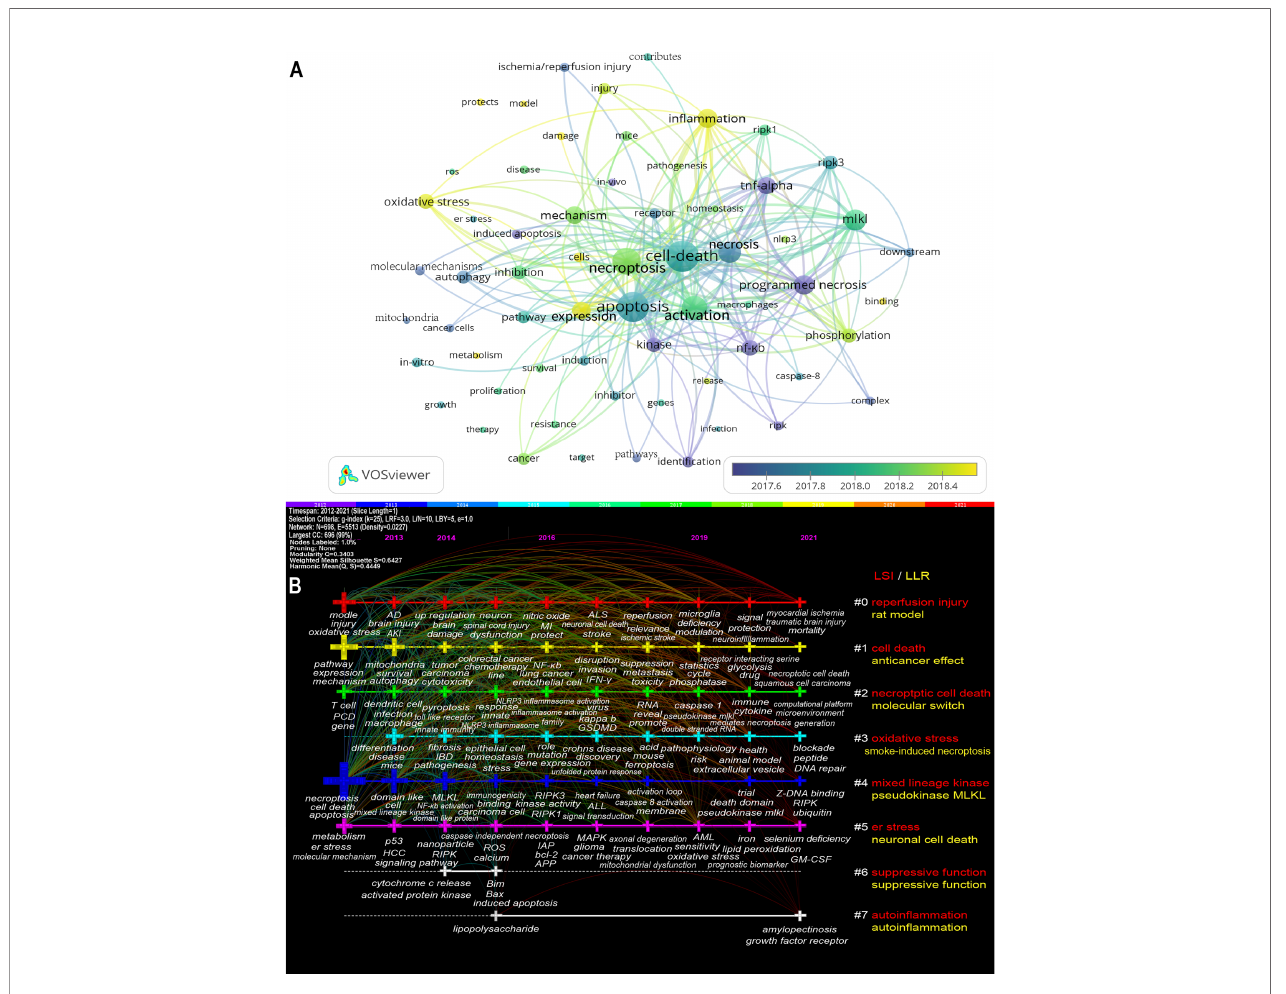
FIGURE 8 | The overlay map (A) and timeline view (B) of keywords related to necroptosis. (A) Keywords appeared ≥ 50, max lines = 200. The node size re fl ects the co-occurrence frequencies, the link indicates the co-occurrence relationship, the thickness of the link is proportional to the number of times two keywords co-occur, and the color indicates the average published year. (B) Each horizontal line represents a cluster; the smaller the number, the larger the cluster, and #0 is the largest. The time is at the top, and keywords are located at their fi rst co-occurrence time in the cluster. Cluster labels were extracted from title and abstract information by LSI (red) and LLR (yellow). LSI, light semantic indexing; LLR, log-likelihood ratio; AD, Alzheimer ’ s disease; AKI, acute kidney injury; ALL, acute lymphoblastic leukemia; ALS, amyotrophic lateral sclerosis; AML, Acute Myelocytic leukemia; APP, amyloid precursor protein; bcl-2, B-cell lymphoma-2; er stress, endoplasmic reticulum stress; GM-CSF, granulocyte/macrophage colony-stimulating factor; GSDMD, gasdermin-D; HCC, hepatocellular carcinoma; IAP, inhibitors of apoptosis; IBD, in fl ammatory bowel disease; INF- g , interferon- g ; MI, myocardial infarction; MLKL, mixed lineage kinase domain-like protein; NF- k B, nuclear factor k -light-chain- enhancer of activated B cells; NLRP3, NOD-, LRR- and pyrin domain-containing protein 3; PCD, programmed cell death; RIPK, receptor-interacting protein kinase; RIPK1, receptor-interacting protein kinase-1; RIPK3, receptor-interacting protein kinase-3; ROS, reactive oxygen